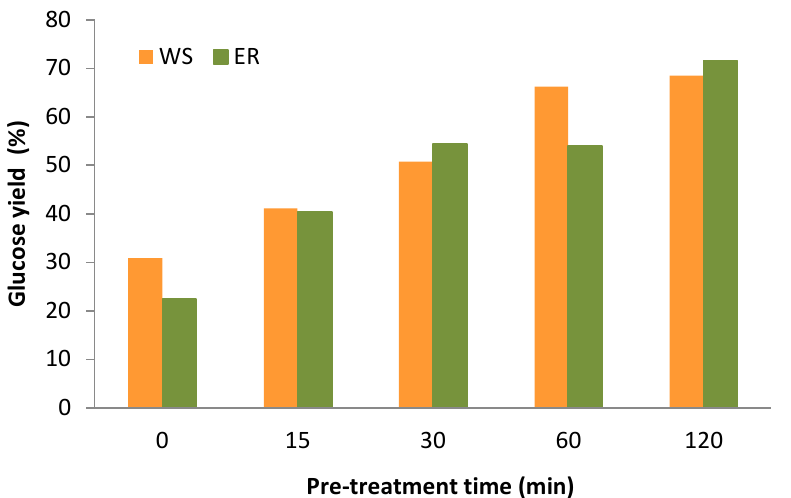
Figure 7. Enzymatic saccharification of ethanol–water organosolv pulp obtained at 190 ◦ C (no catalyst